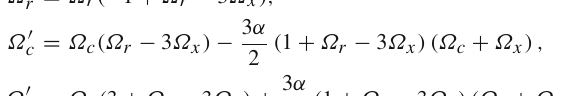
Fig. 3 Phase plot for model Γ 2 T with α = − 0 .